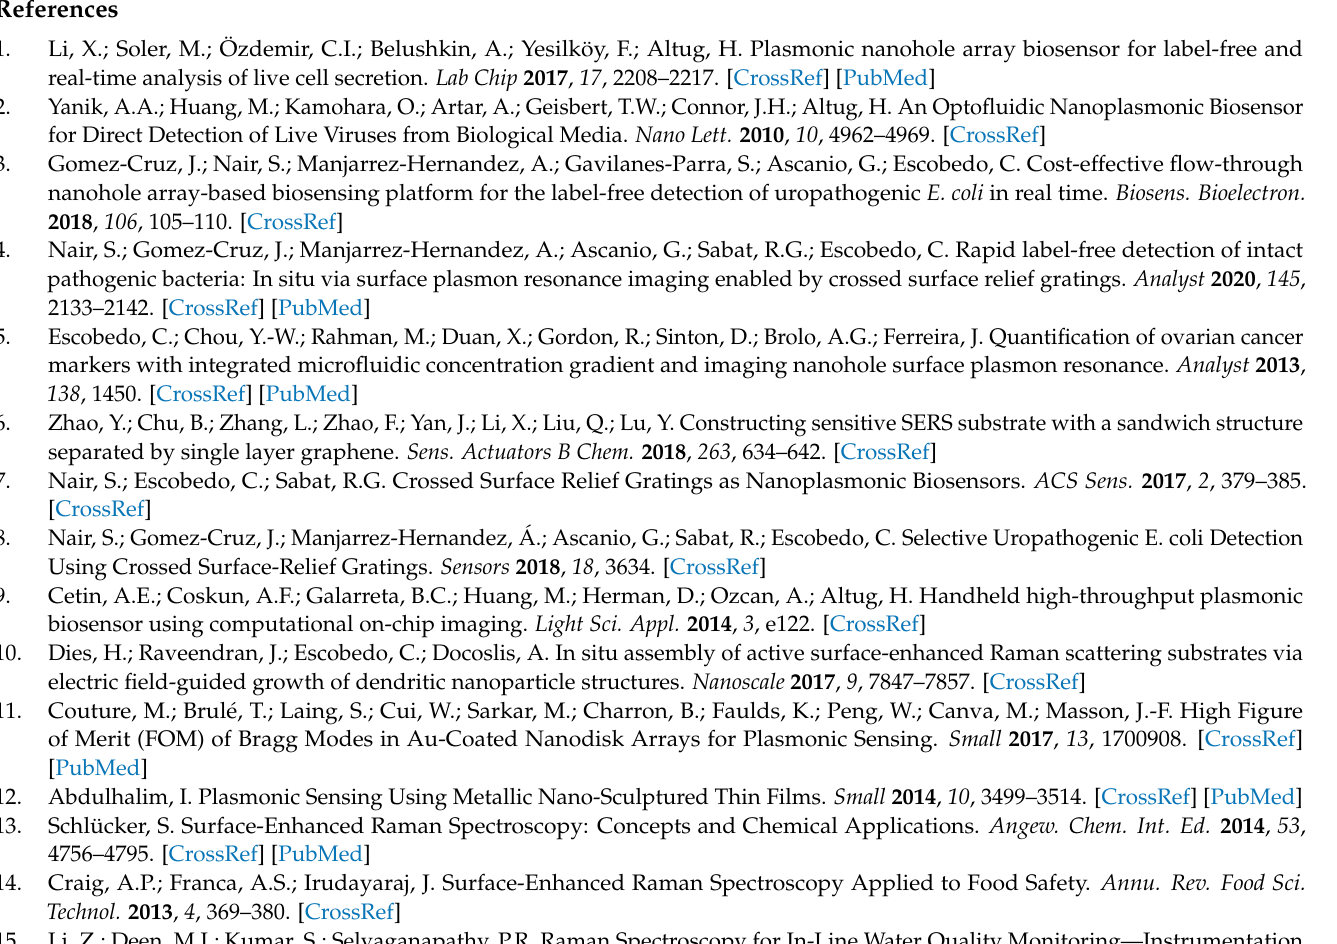
Figure S2. Gold NHA FDTD simulations show the (a) transmission spectrum and the (b) Electric field distribution (| E / E 0 | 4 ) of the electromagnetic Raman enhancement